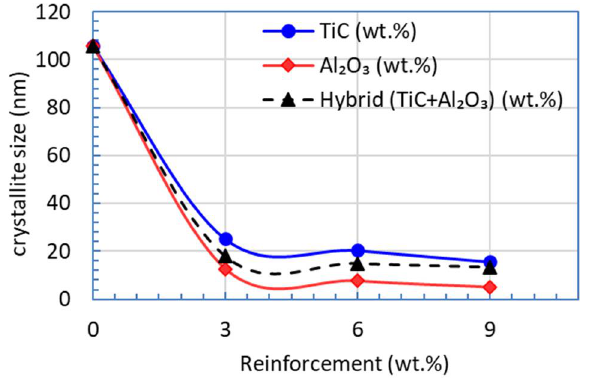
Figure 3. The effect of ceramic additions on the crystallite size.